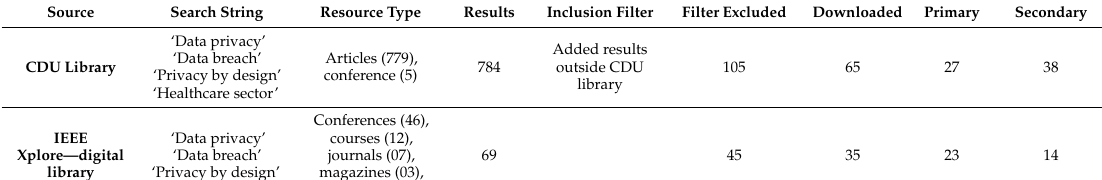
Table 1. Sources identified for related research